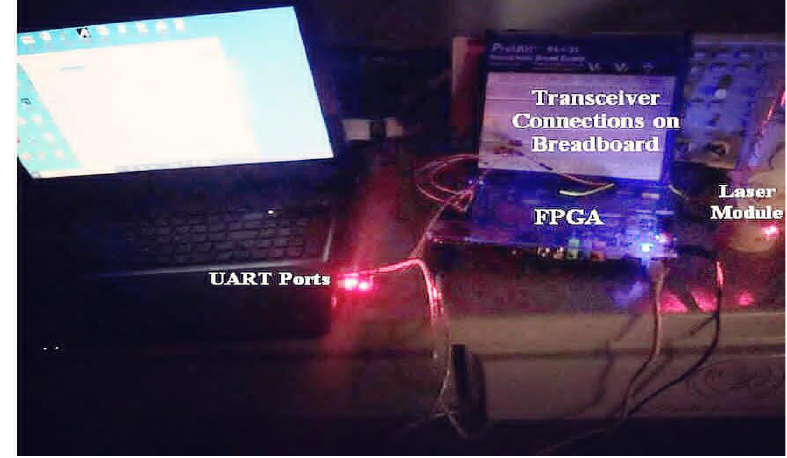
Figure 18. Transceiver Hardware System Implementation .